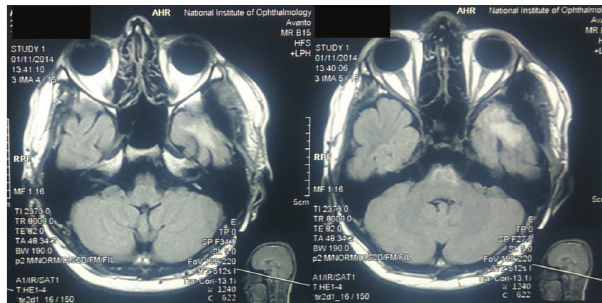
Figure 5: Post-ChemoRT images showing no recurrent/residual tumor.